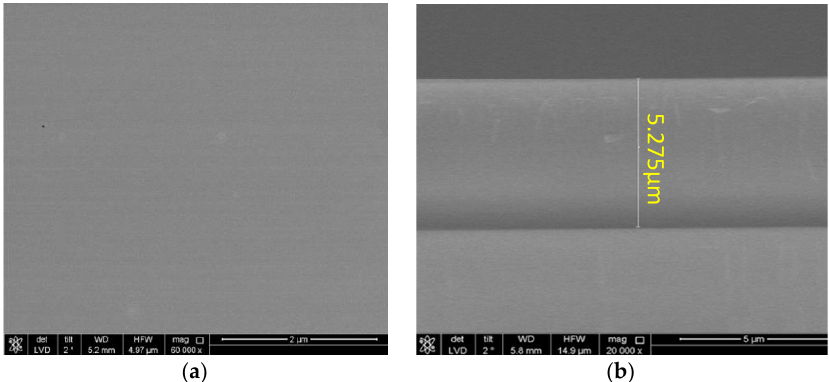
Figure 6. The AFM characterizing picture of the prepared SiO 2 overlay, ( a ) surface characteristic; and ( b ) thickness measurement.